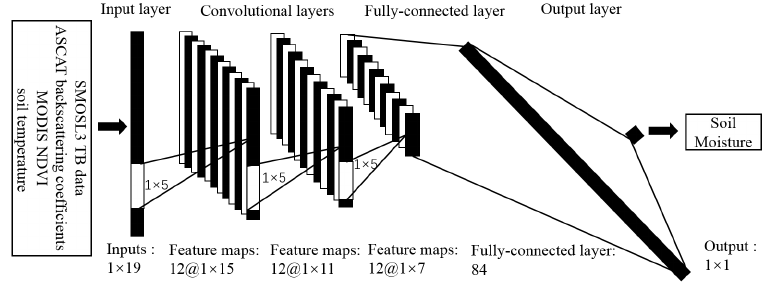
Figure 2. The architecture of the DCNN